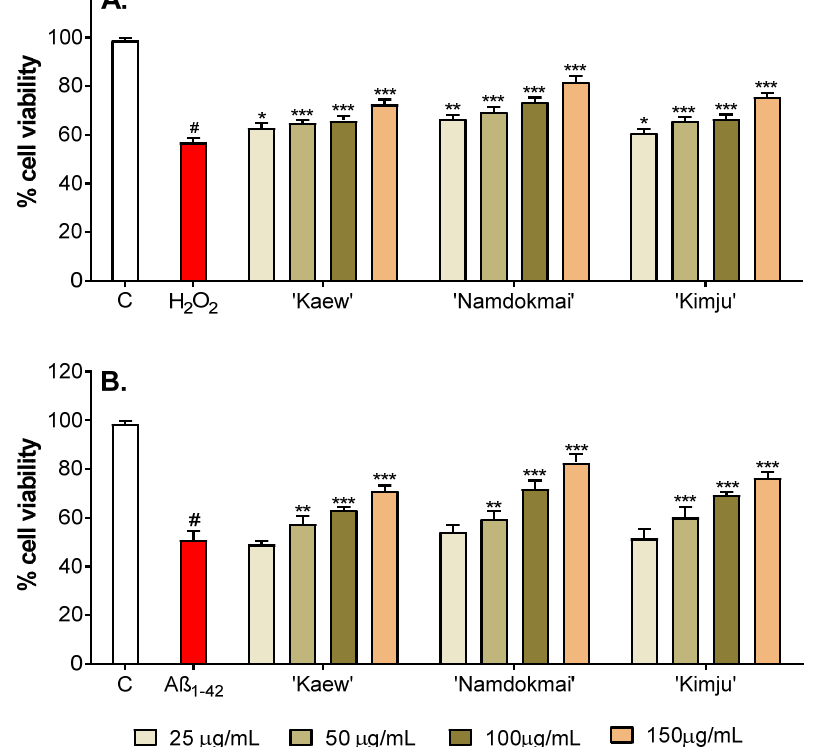
Figure 2. Neuroprotective effect of fruit extracts ( M. indica ‘Kaew’, M. indica ‘Namdokmai’, and P. guajava ‘Kimju’) on oxidative damaged PC-12 cells examined using a resazurin assay. Percentage of cell viability induced by ( A ) H 2 O 2 and ( B ) A β 1–42 was compared to the untreated control group, while co-treatment between selected fruit extracts at different concentrations (25, 50, 100 and 150 µ g/mL) and oxidative inducers were compared to its oxidative inducer treated group. C: untreated control; H 2 O 2 : H 2 O 2 -treated control; A β 1–42 : A β 1–42 -treated control; # significance at p < 0.05 compared to the untreated control, * significance at p < 0.05, ** significance at p < 0.01 and *** significance at p < 0.001 compared with either H 2 O 2 - or A β 1–42 -treated cells using one-way analysis of variance (ANOVA) followed by Tukey’s multiple comparisons test.